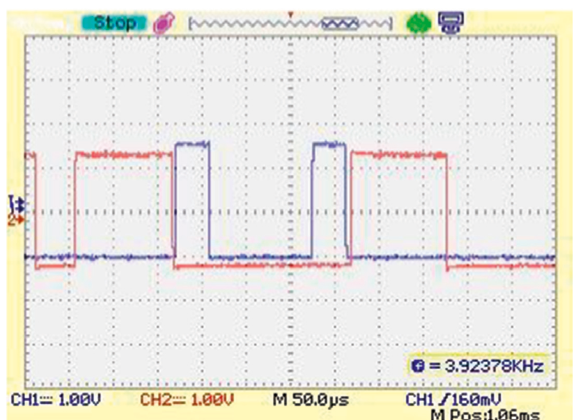
Figure 26: Driving part working waveform.